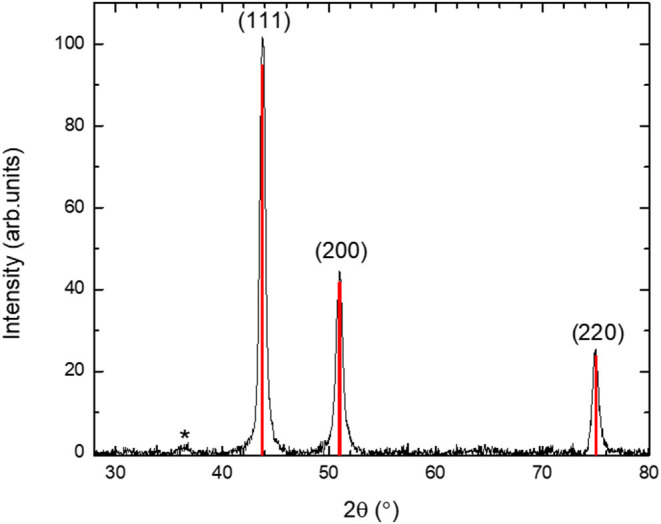
XRD data for the Ni1-xFex mat containing submicron fibers after grinding. Also shown are the Miller indices for FCC Ni1-xFex. A weak impurity phase is indicated by an asterisk and it is in the region where the main FCC FeO and NiO XRD peaks are expected.